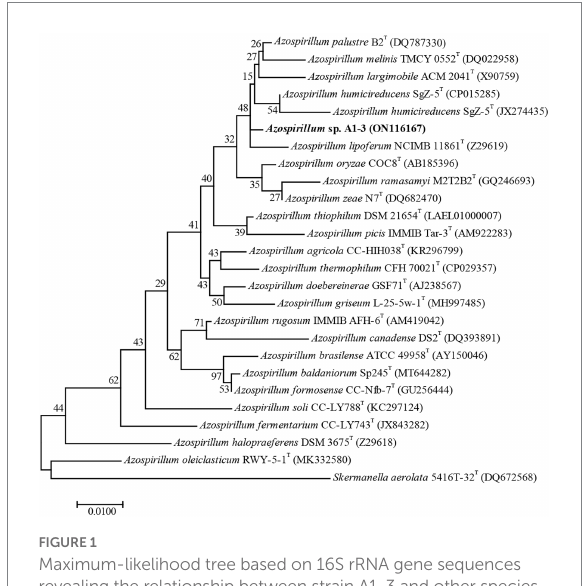
FIGURE 1 Maximum-likelihood tree based on 16S rRNA gene sequences revealing the relationship between strain A1-3 and other species of the genus Azospirillum . Skermanella aerolata 5416 T-32 T was used as an out-group. Bar, 0.01 substitutions per nucleotide position.